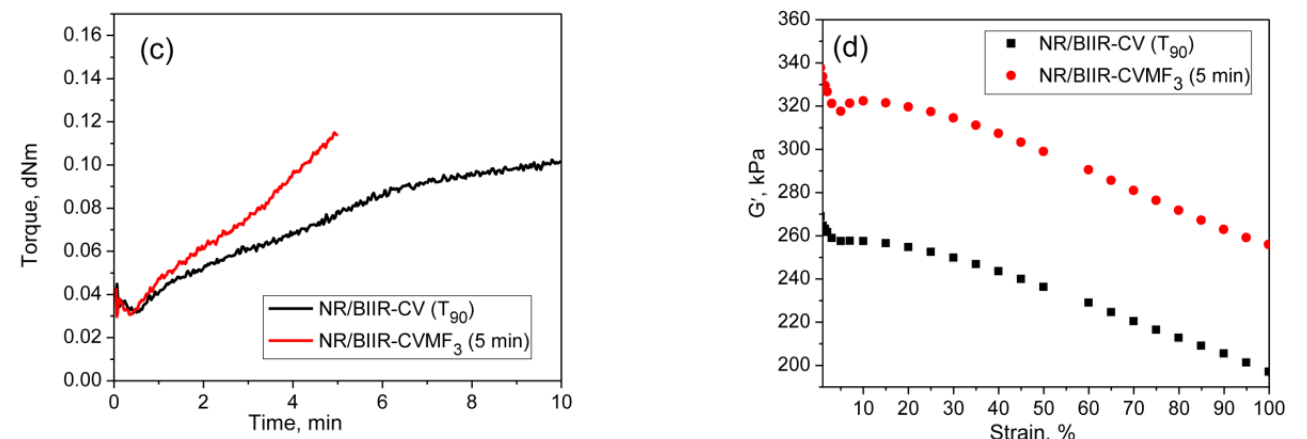
Figure 6. RPA cure curves at 170 °C and the corresponding strain-sweep curves at 40 °C of ( a , b ) T 90 cured NR/CR-CV and 8 min cured NR/CR-CVMF 3 and ( c , d ) T 90 cured NR/BIIR-CV and 5 min cured NR/BIIR-CVMF 3.